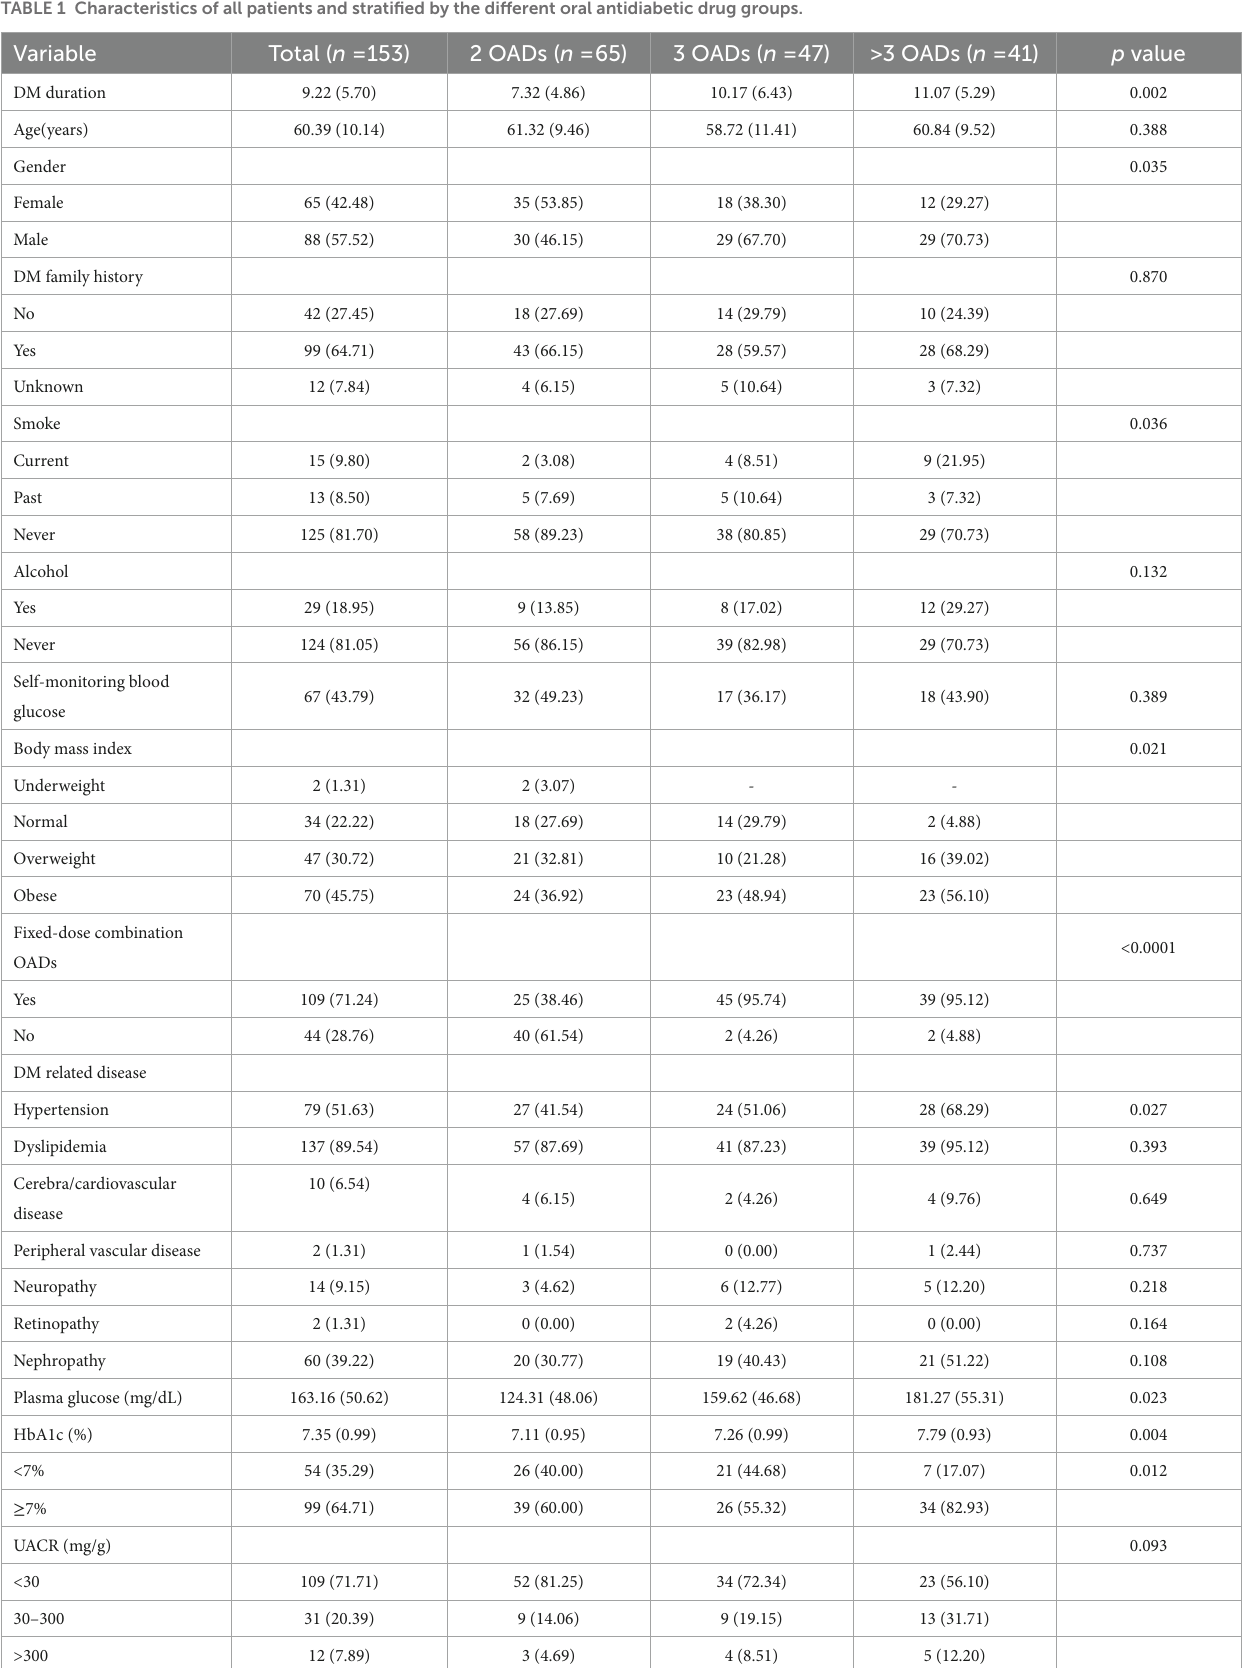
TABLE 1 Characteristics of all patients and stratified by the different oral antidiabetic drug groups. Variable Total ( n =